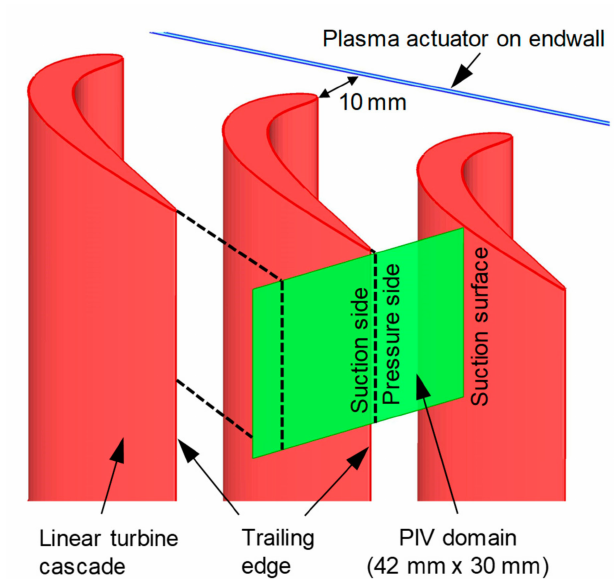
Figure 10. Particle image velocimetry (PIV) measurement